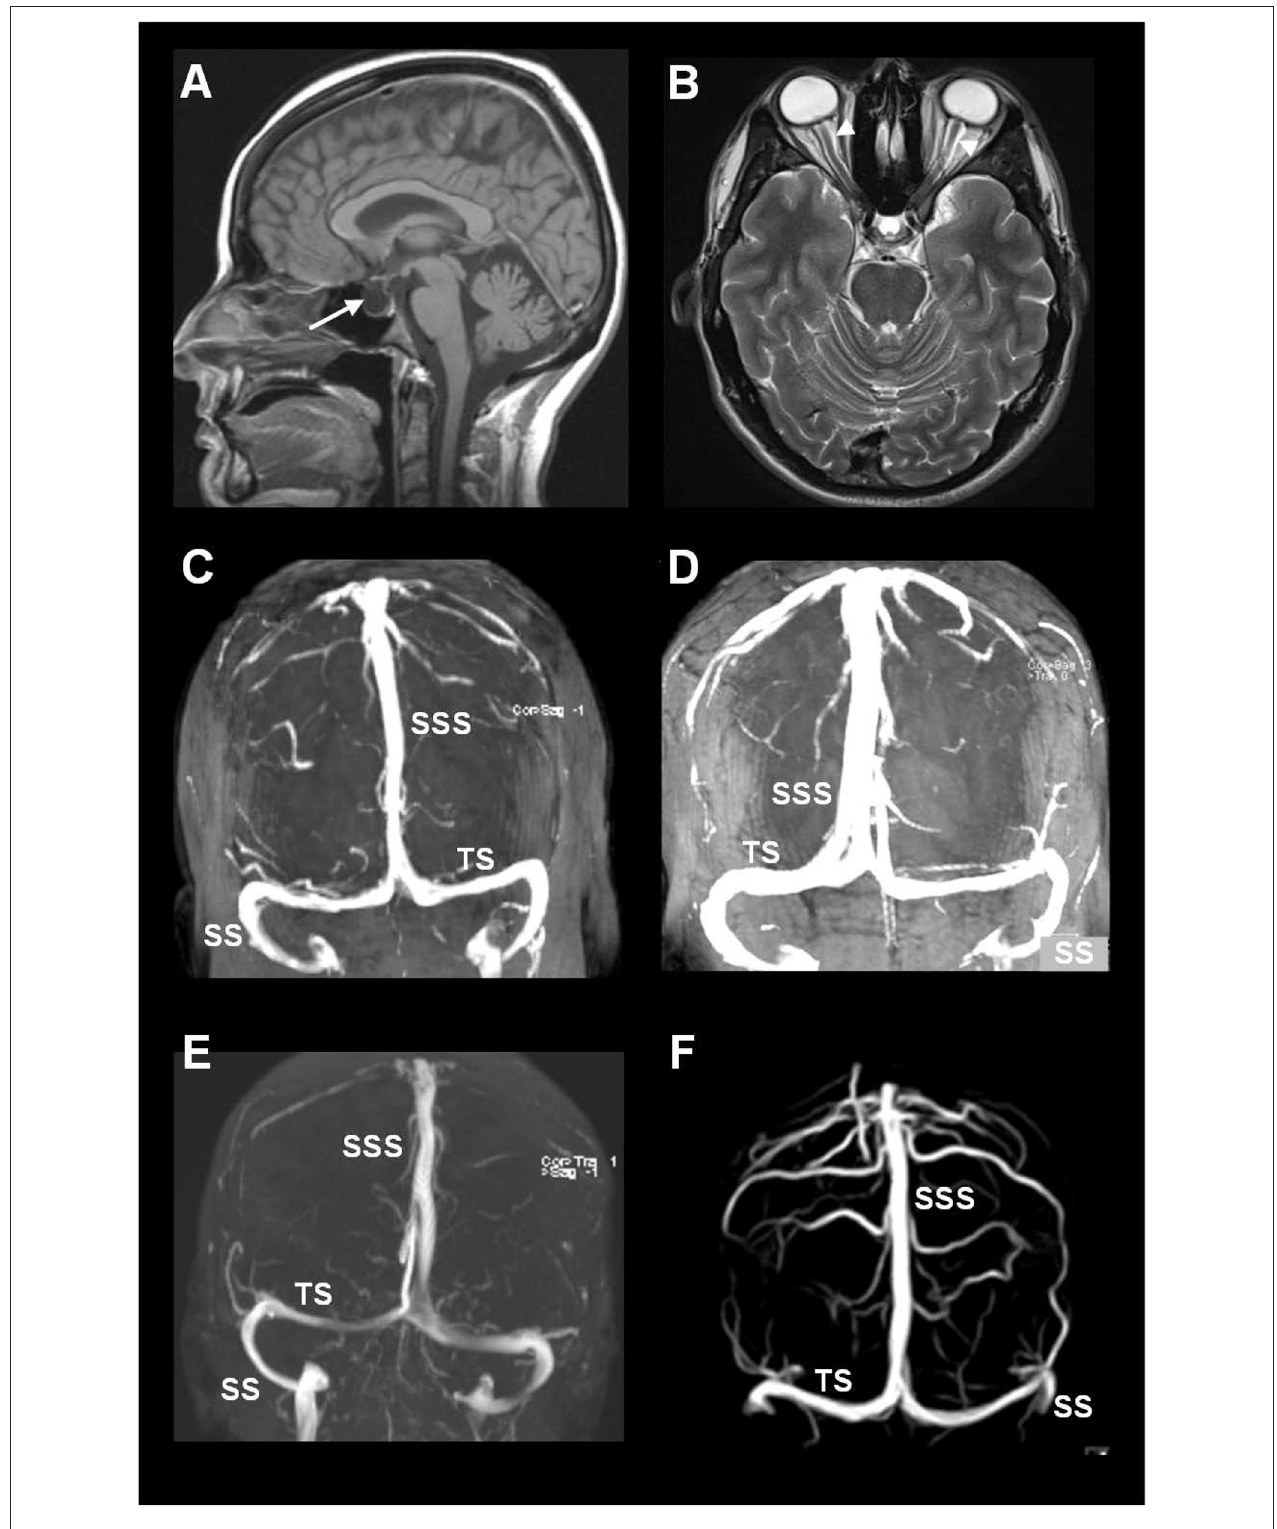
FIGURE 2 | MRI biomarkers indicative of CSF disturbance in IIH include the presence of (A) empty sella (arrow) and (B) distension of the perioptic subarachnoid spaces (arrowheads). (C–F) Sinus vein stenosis was assessed using MRI venography, here illustrated by MRI venography from four of the included patients with IIH. The image shows the transverse sinus (TS), sigmoid sinus (SS), and the superior sagittal sinus (SSS).